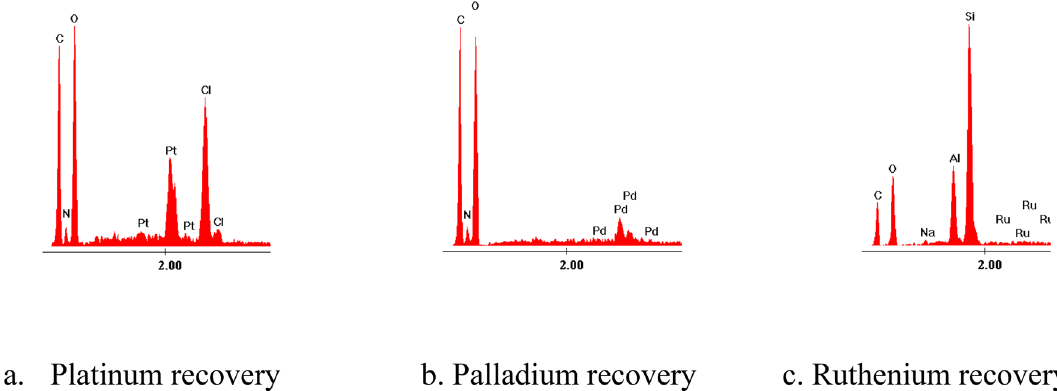
Figure 14. Energy dispersive X-ray analysis, EDX after recovery metallic